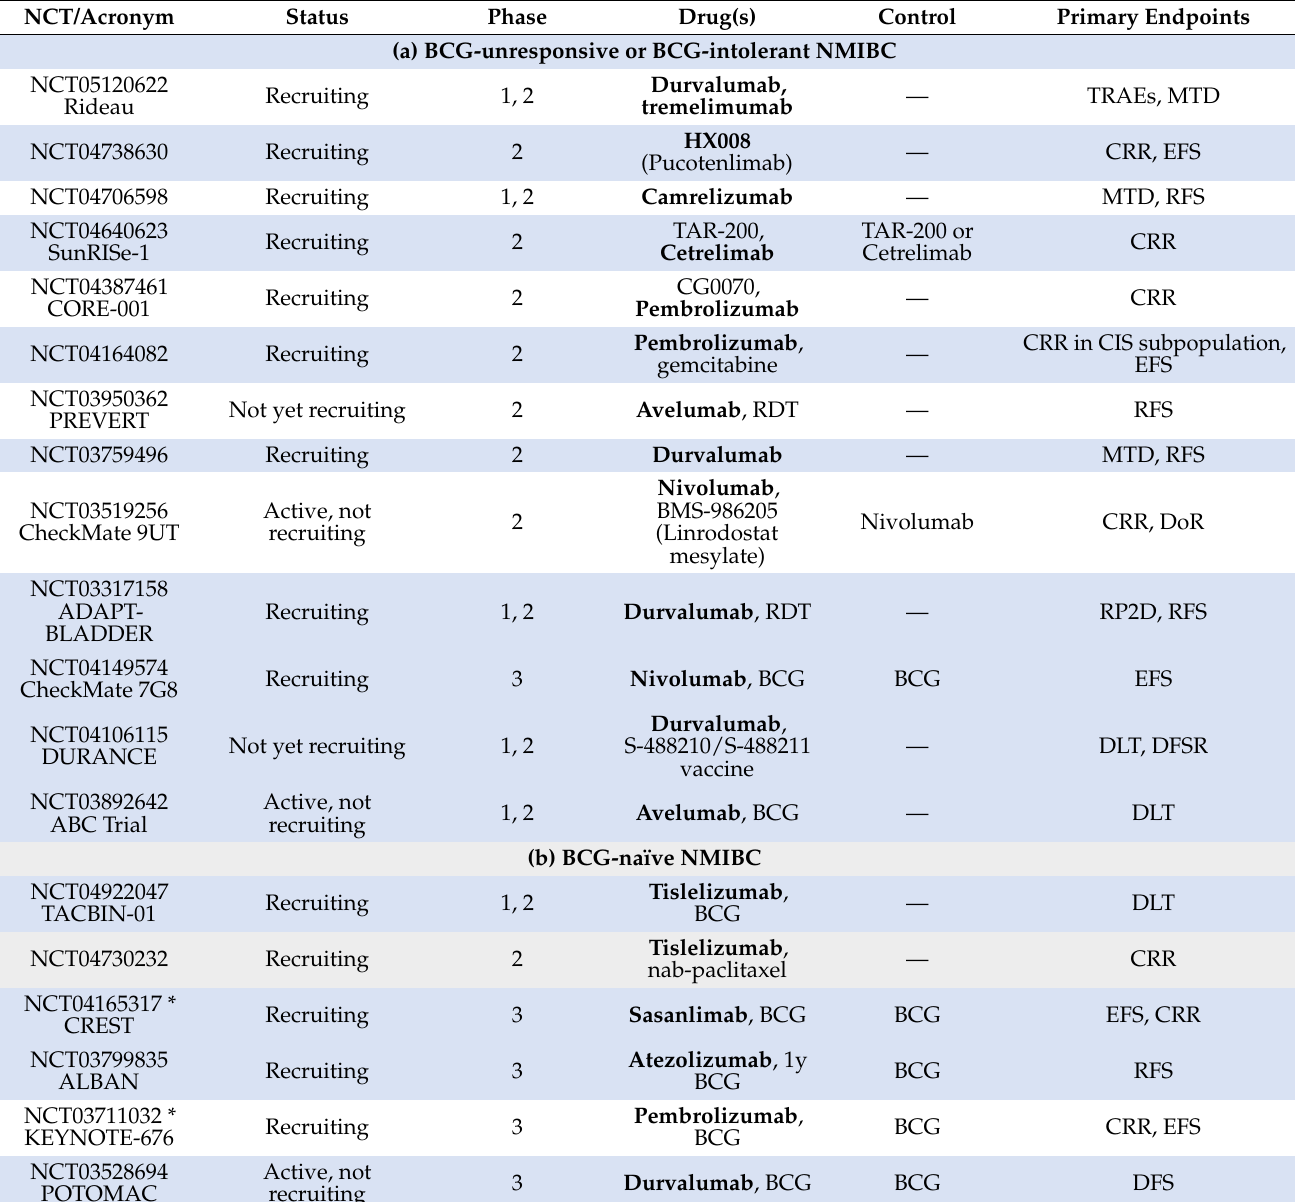
Table 2. Ongoing clinical trials testing ICIs (in bold font) alone or in combination in